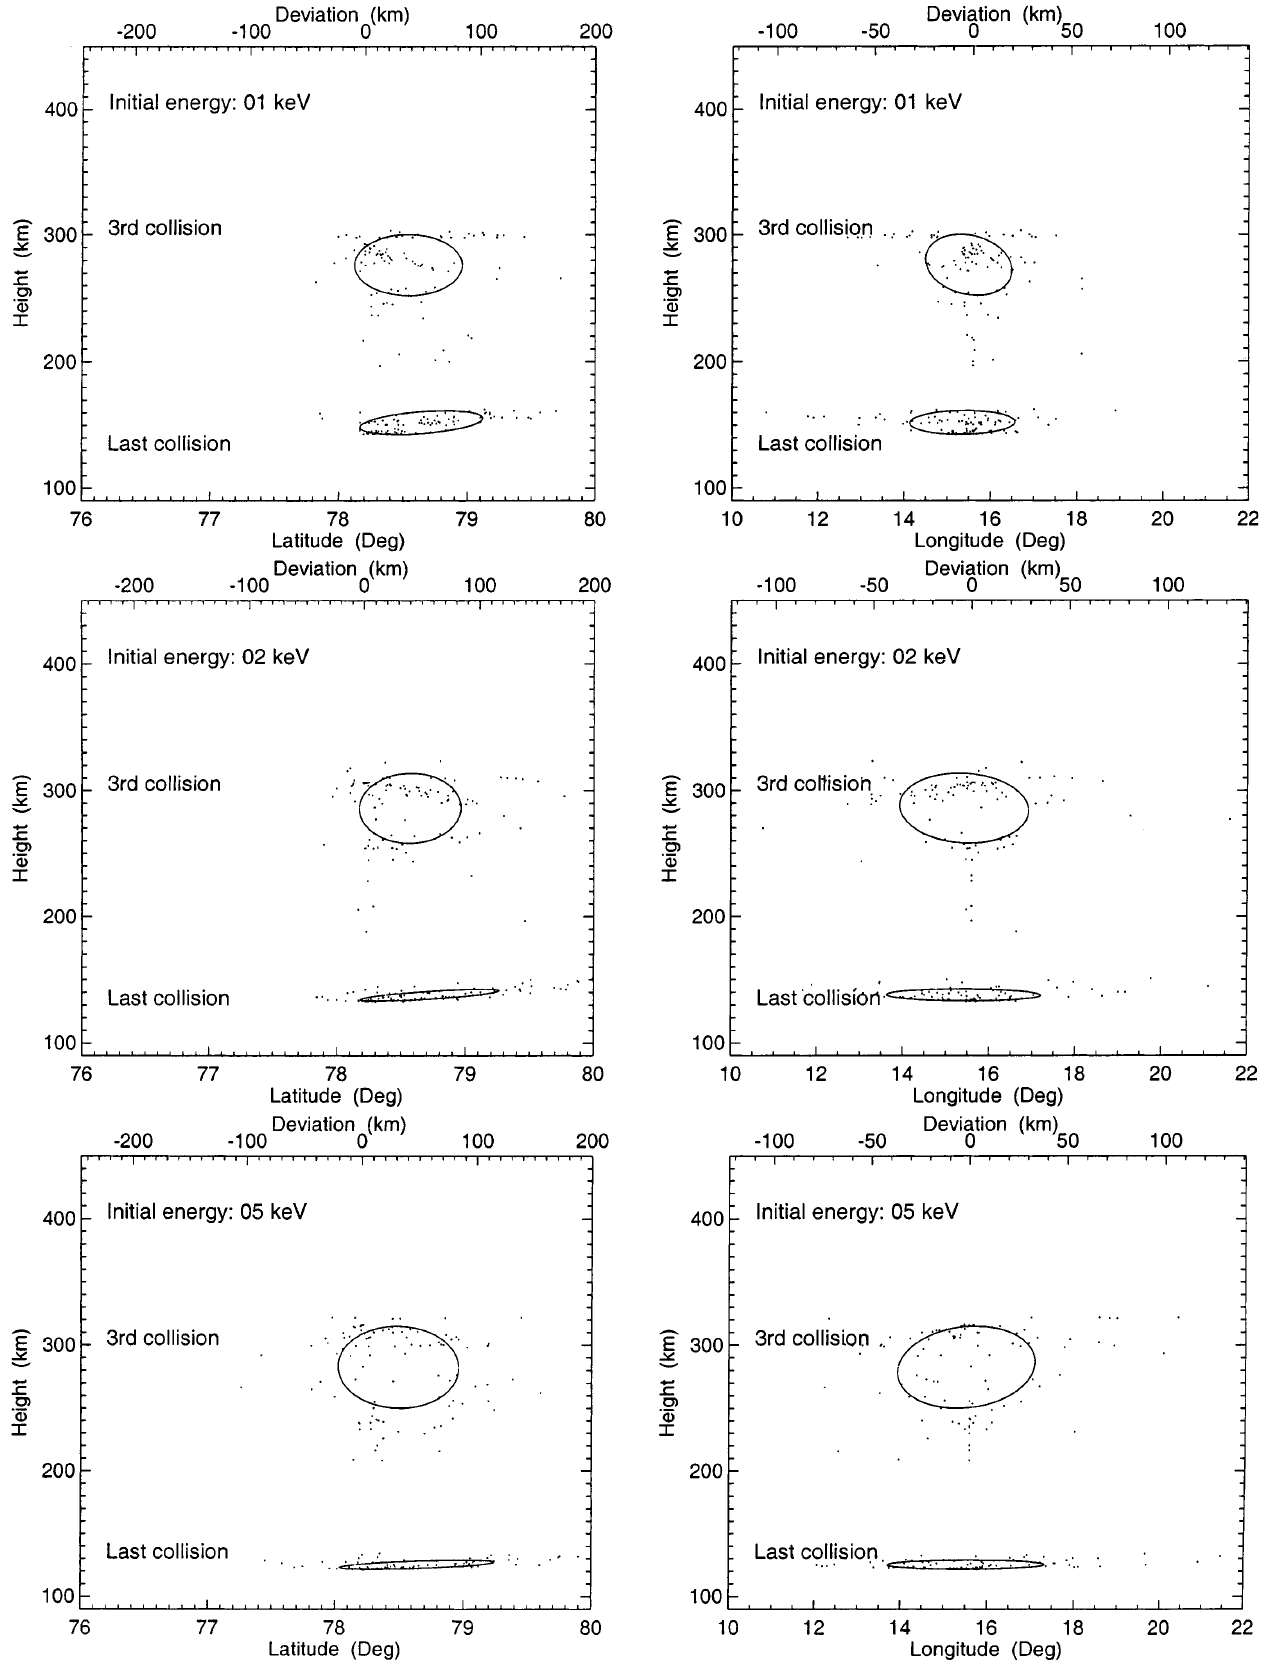
Fig. 1. Latitudinal and longitudinal dispersion at third and last collision, for initial energies of 1, 2 and 5